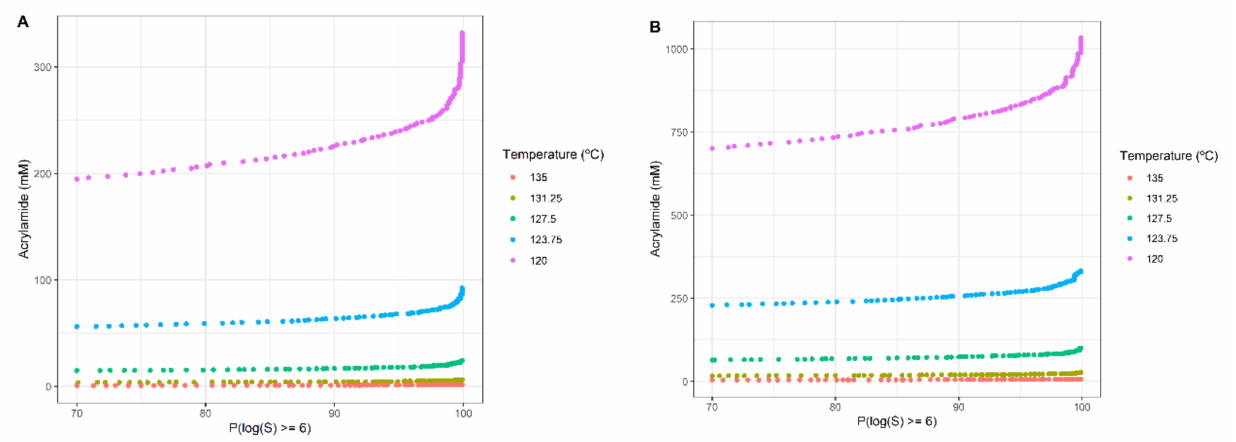
Figure 6. Acrylamide formed in a heat treatment that inactivates the microorganism for different values of P ( log 10 S ≥ 6 ) : potato puree ( A ) and prune juice ( B